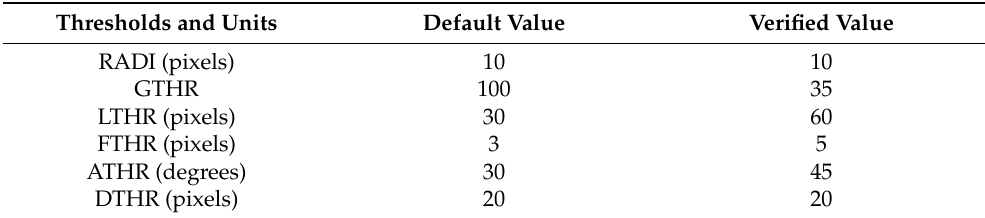
Table 5. Default and verified values of the PCI Geomatica LINE module parameters for microfrac- ture extraction.